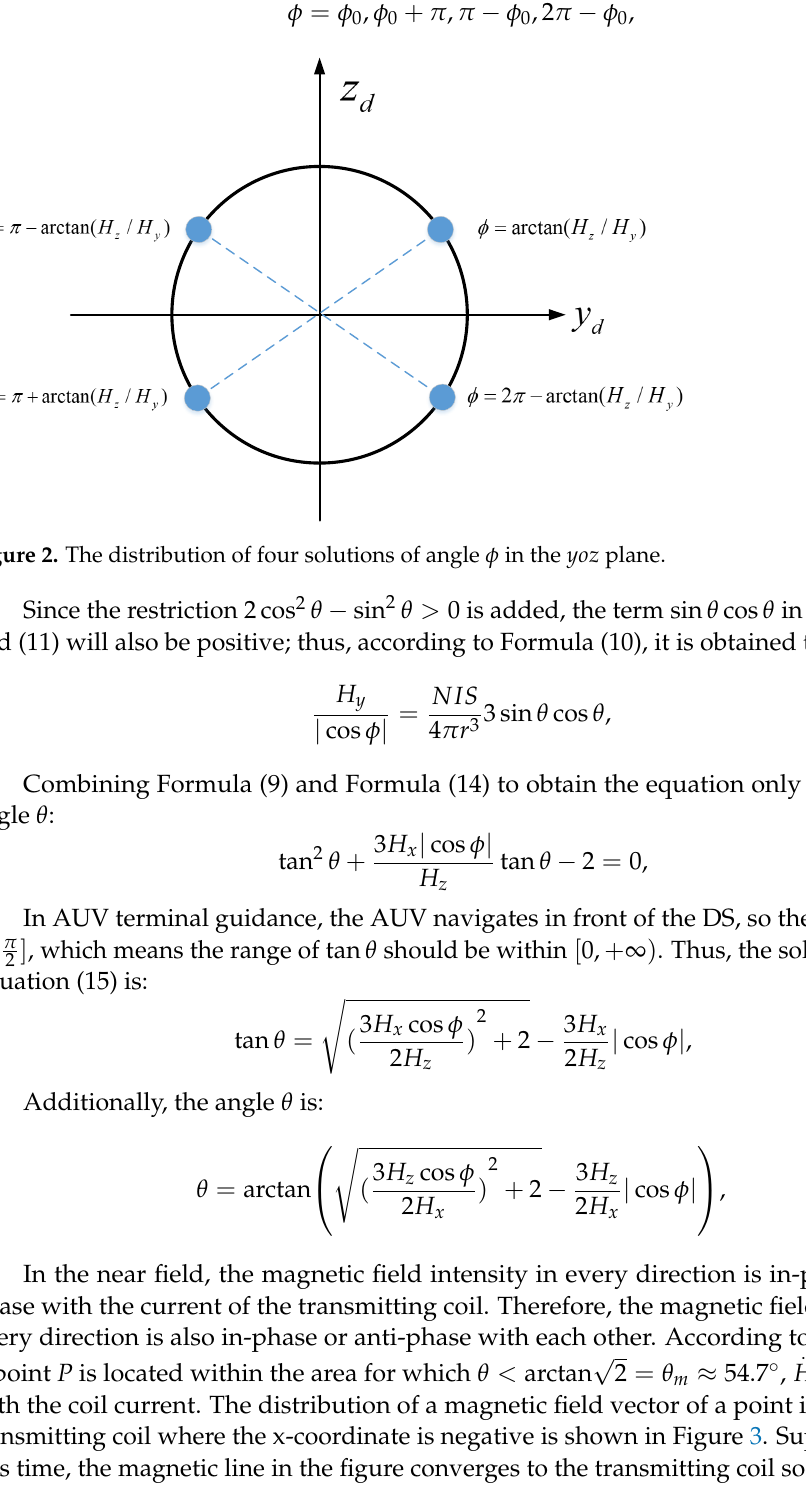
tions of angle φ within the range of [ 0, 2 π ] , as shown in Figure 2. Assuming that angle φ 0 is equal to acrtan ( H z / H y ) , then the four possible solutions of angle φ are: